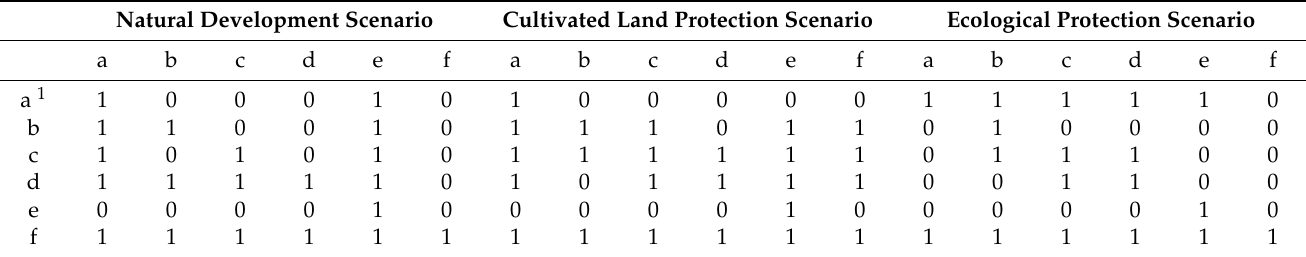
Table 2. Multi-scenario cost